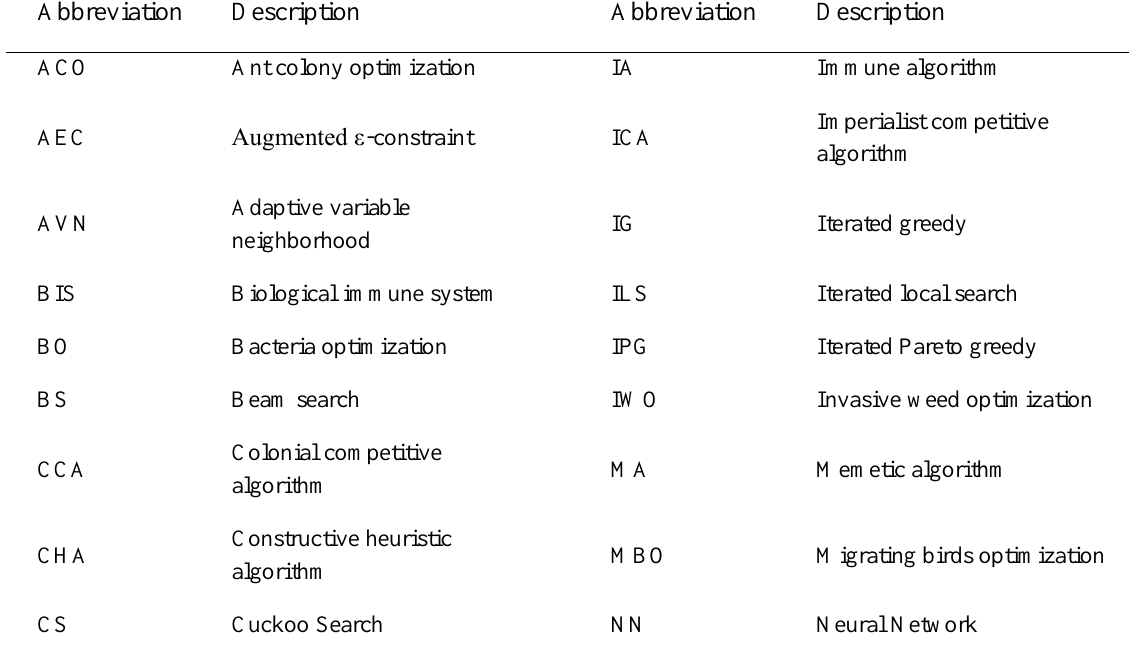
Table 1. Abbreviation of